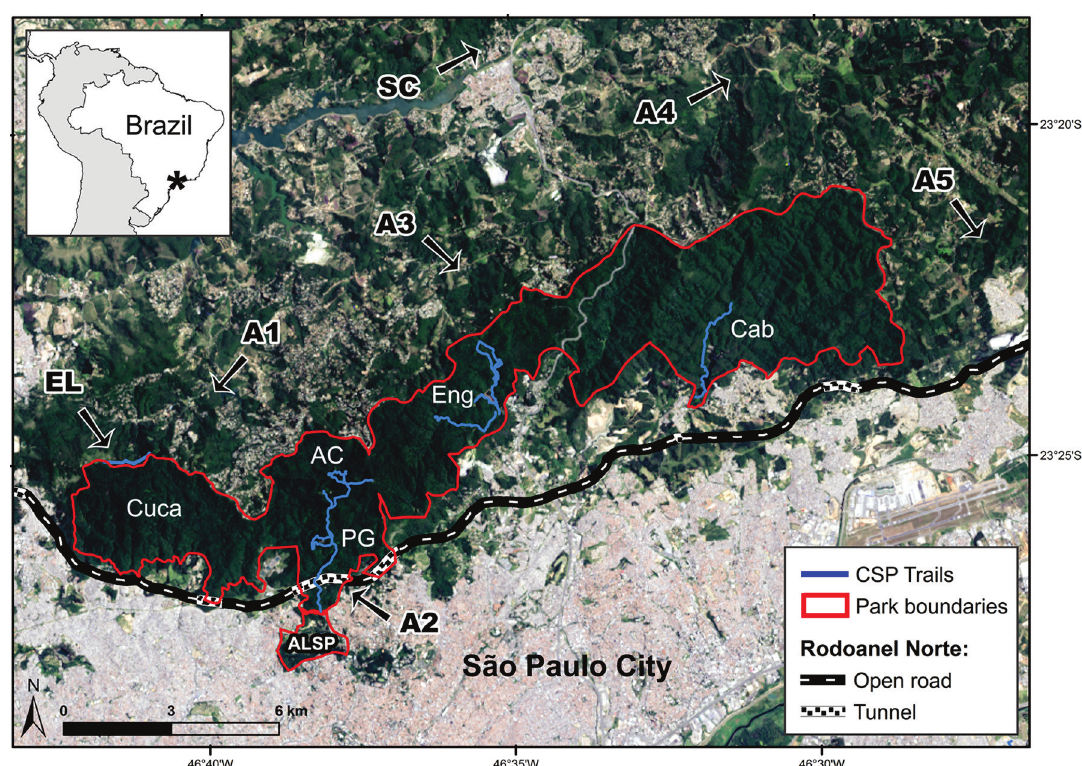
Figure 1. Serra da Cantareira locations surveyed in this study. In the urban slope are Cantareira State Park admnistrative zones and their trails: AC = Águas Claras; PG = Pedra Grande; Eng = Engordador; Cab = Cabuçu; EL = Estrada do Lenhador; Alberto Löfgren State Park (ALSP) and A2. In the inner slope are A1, A3, A4, A5 and SC = Sítio Capuavinha private